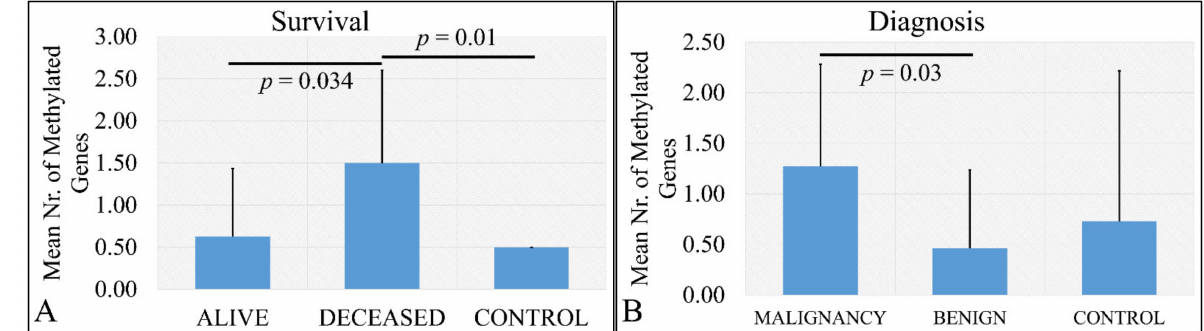
Figure 6. Number of methylated genes with respect to survival ( A ) and diagnosis ( B ). Analysis of the correlation of gene methylation to clinical characteristics patients have. In particular, it appeared that there is a significant difference in the number of methylated genes between deceased patients and control samples, as well as alive patients and control samples ( A ) and between malignant and benign tumors ( B ).